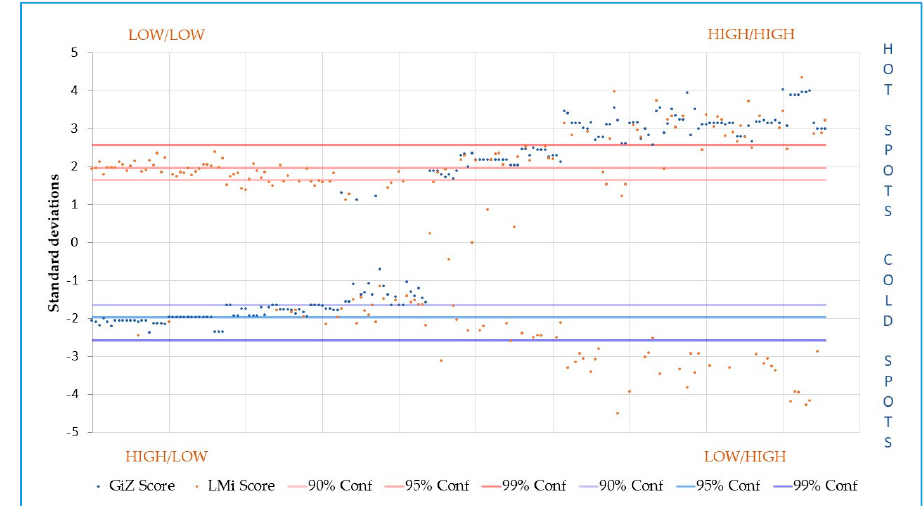
Figure 9. Results obtained with GiZ Score and LMiZ Score.